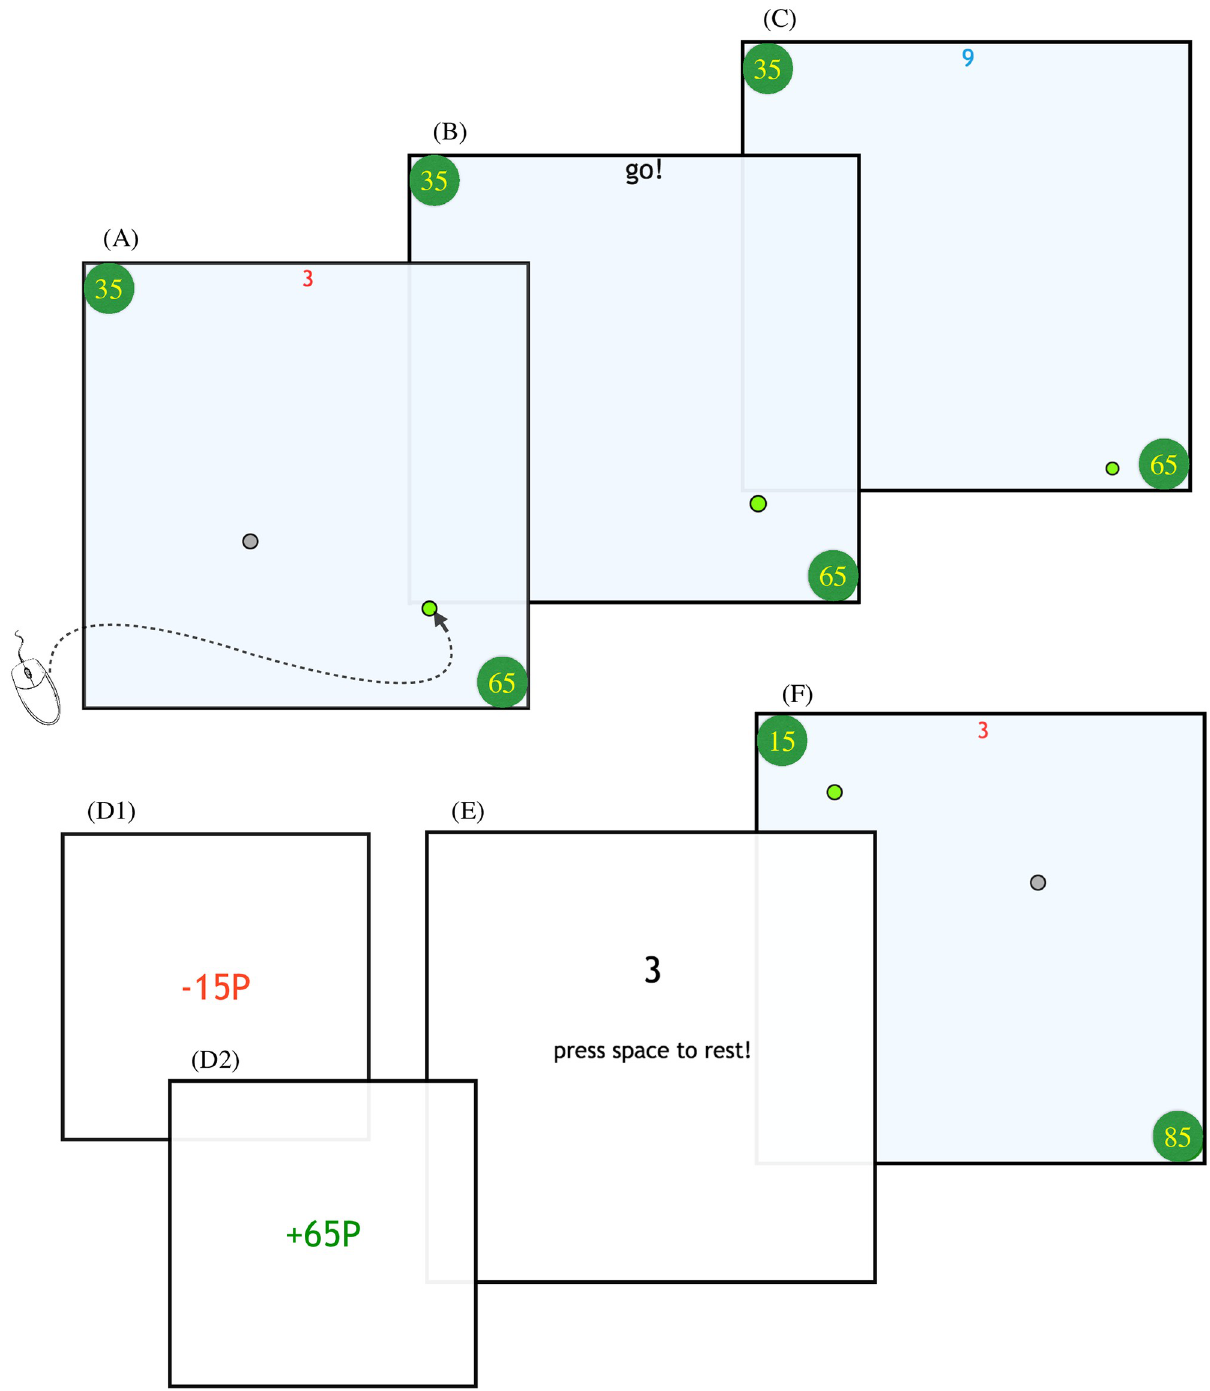
Fig 1. The timeline of a trial. This trial is of type OG (see Fig 2). This is the only trial type where r ( g − ) is larger than r ( g + ), intended to prevent subjects from starting to assume that the larger goal would always be further away in DGTs. From top-left to bottom-right: ( A ) vehicle selection phase. Subjects had 5 seconds (3 seconds of which are left in the figure) to choose a vehicle using the mouse pointer (whose movement is shown by the curved arrow). The ultimate goals are shown as green circles whose values in pence are shown as numbers inside each. ( B ) Any unchosen vehicle is removed, and a “go!” cue starts the movement phase of the trial. The subject then had 14 seconds to drive the chosen vehicle to reach one of the goals to win the amount shown. Otherwise, they lost 15p. ( C ) the trial is in progress—in this case with 9s left (top centre) for moving. ( D1 ) shows what subjects see upon expiry of the allowed time; the amount lost (15p) is displayed in red, and is accompanied by a noxious sound. ( D2 ) shows what subjects see if they touched the